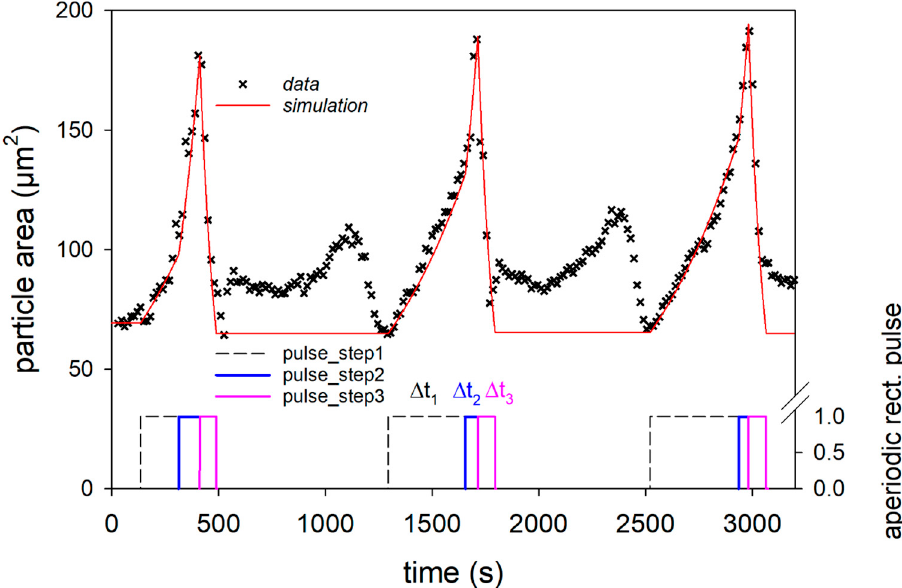
Figure 5. Simulation of the sequence of three swelling cycles using a sequential swelling model and aperiodic square pulses for each step.